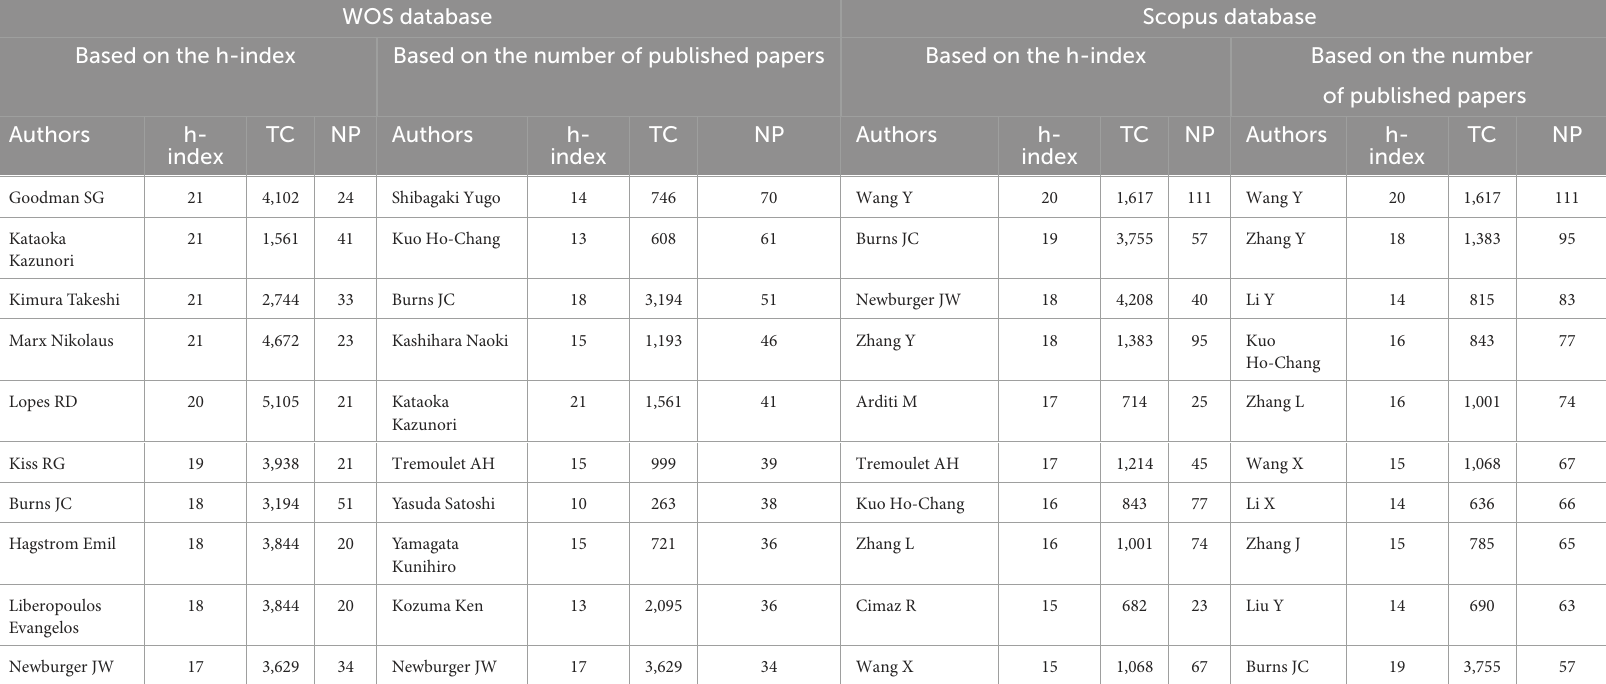
TABLE 2 The h-index, total citations and numbers of published papers of the top 10 most influential and productive